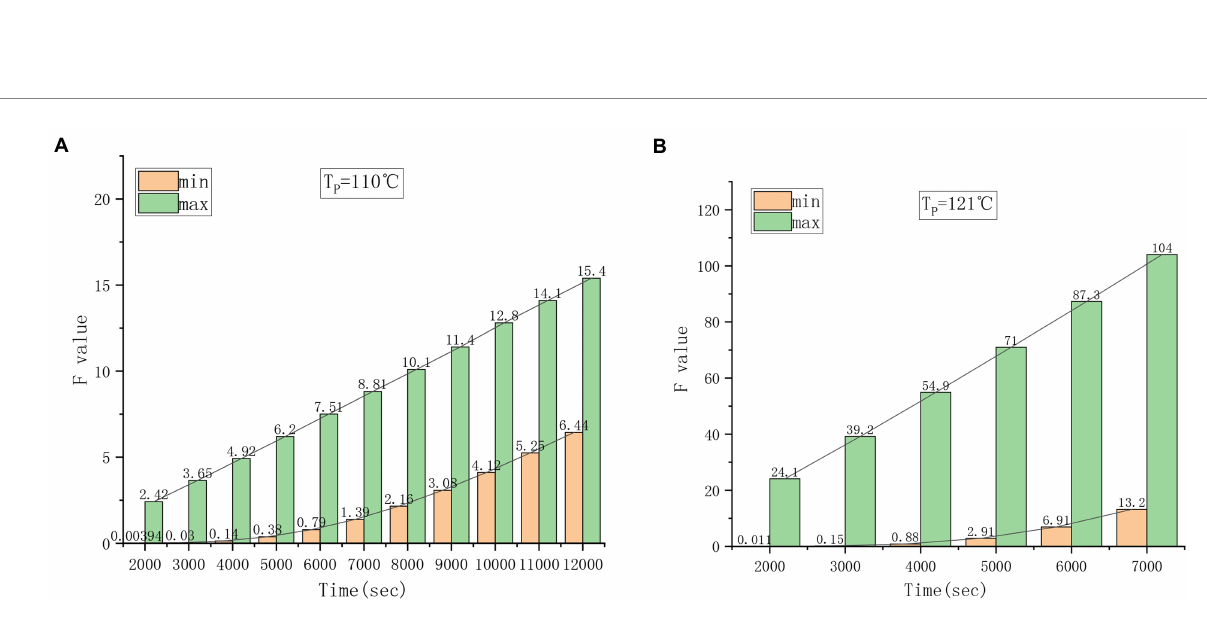
FIGURE. 6 Changes in Fmax and Fmin at different sterilization temperatures. (A) 110 ° C sterilization temperature. (B) 121 ° C sterilization